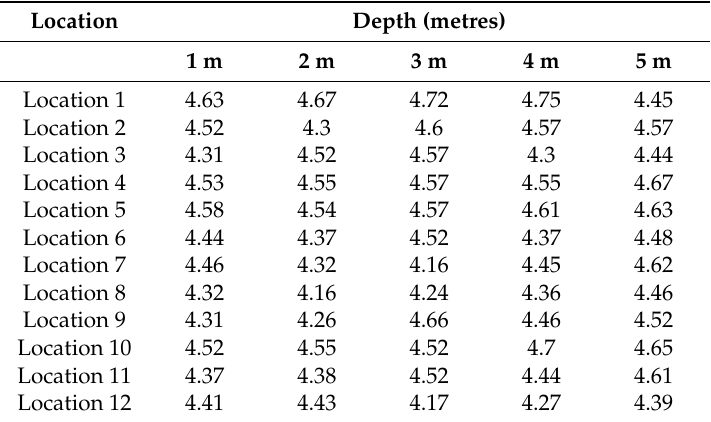
Table 3. Suspend Solids Concentration per sample location and depth (kg/m 3